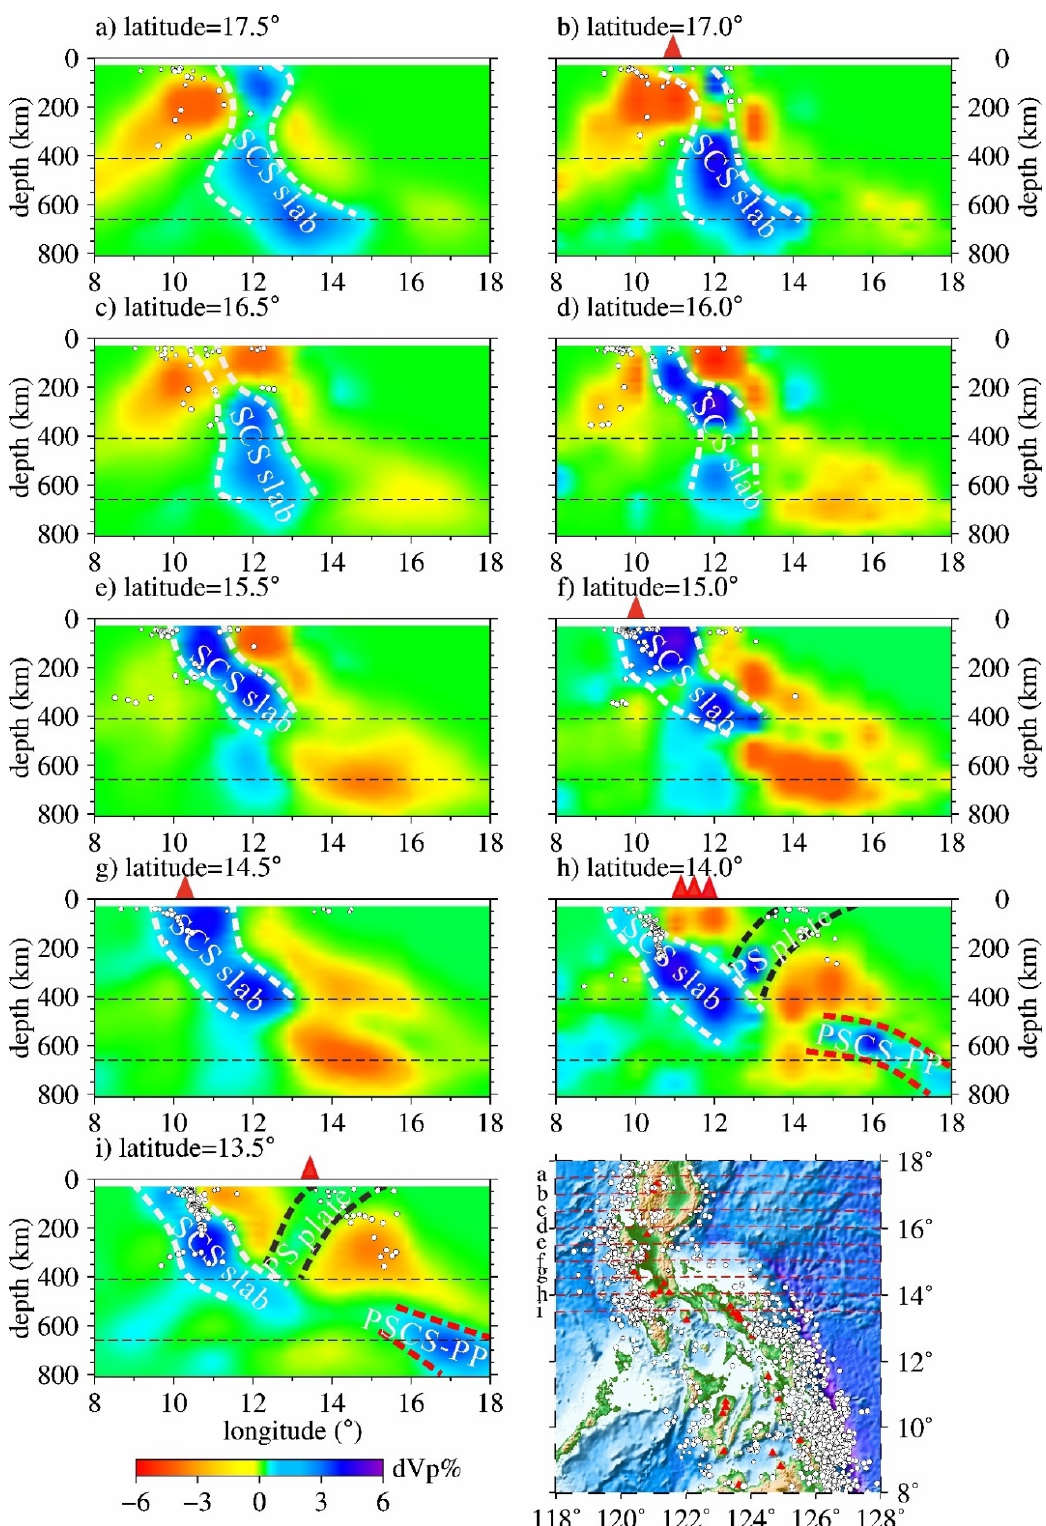
Figure 8. Nine velocity cross-sections along different latitudes. Fast anomalies are denoted by blue color, slow anomalies are denoted by red color. The color bar of the anomaly is located at the bottom. Red triangles indicate volcanoes. The two black horizontal dotted lines indicate the interfaces at 410 km and 660 km, respectively. White dots, gray dot and black dots indicate the location of source for the earthquakes occurred within 0.25° on both sides of the profile, respectively. These data were obtained from the ISC seismic catalog [23].